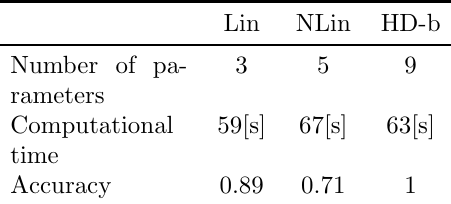
Table 2: Benchmarking table